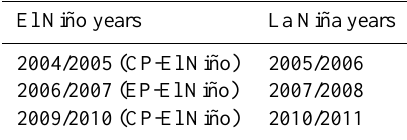
Table 1. El Niño and La Niña years since 2004. “CP-El Niño” rep- resents central Pacific El Niño, and “EP-El Niño” represents eastern Pacific El